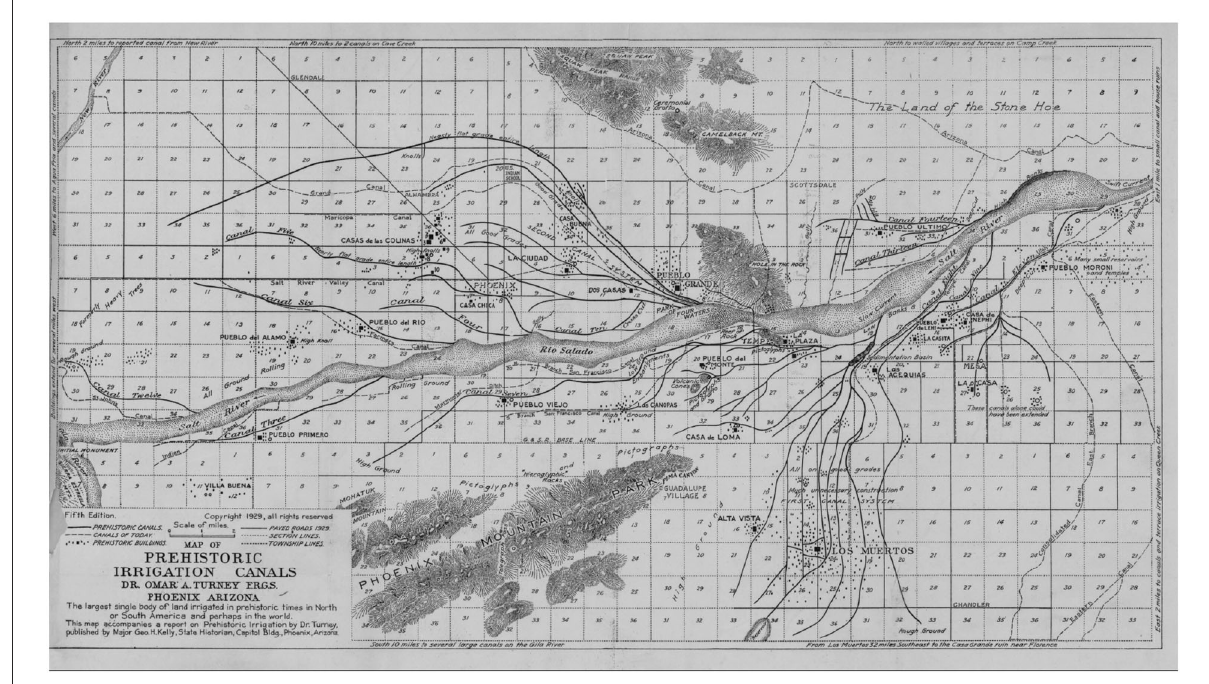
FIGURE3 Map of Hohokam prehistoric irrigation canals [Turney, 1929; https://repository.arizona.edu/bitstream/handle/10150/623395/azu_h9791_a72_ h6_02_02_art2_w.pdf?sequence=1andisAllowed=y (accessed December 16,